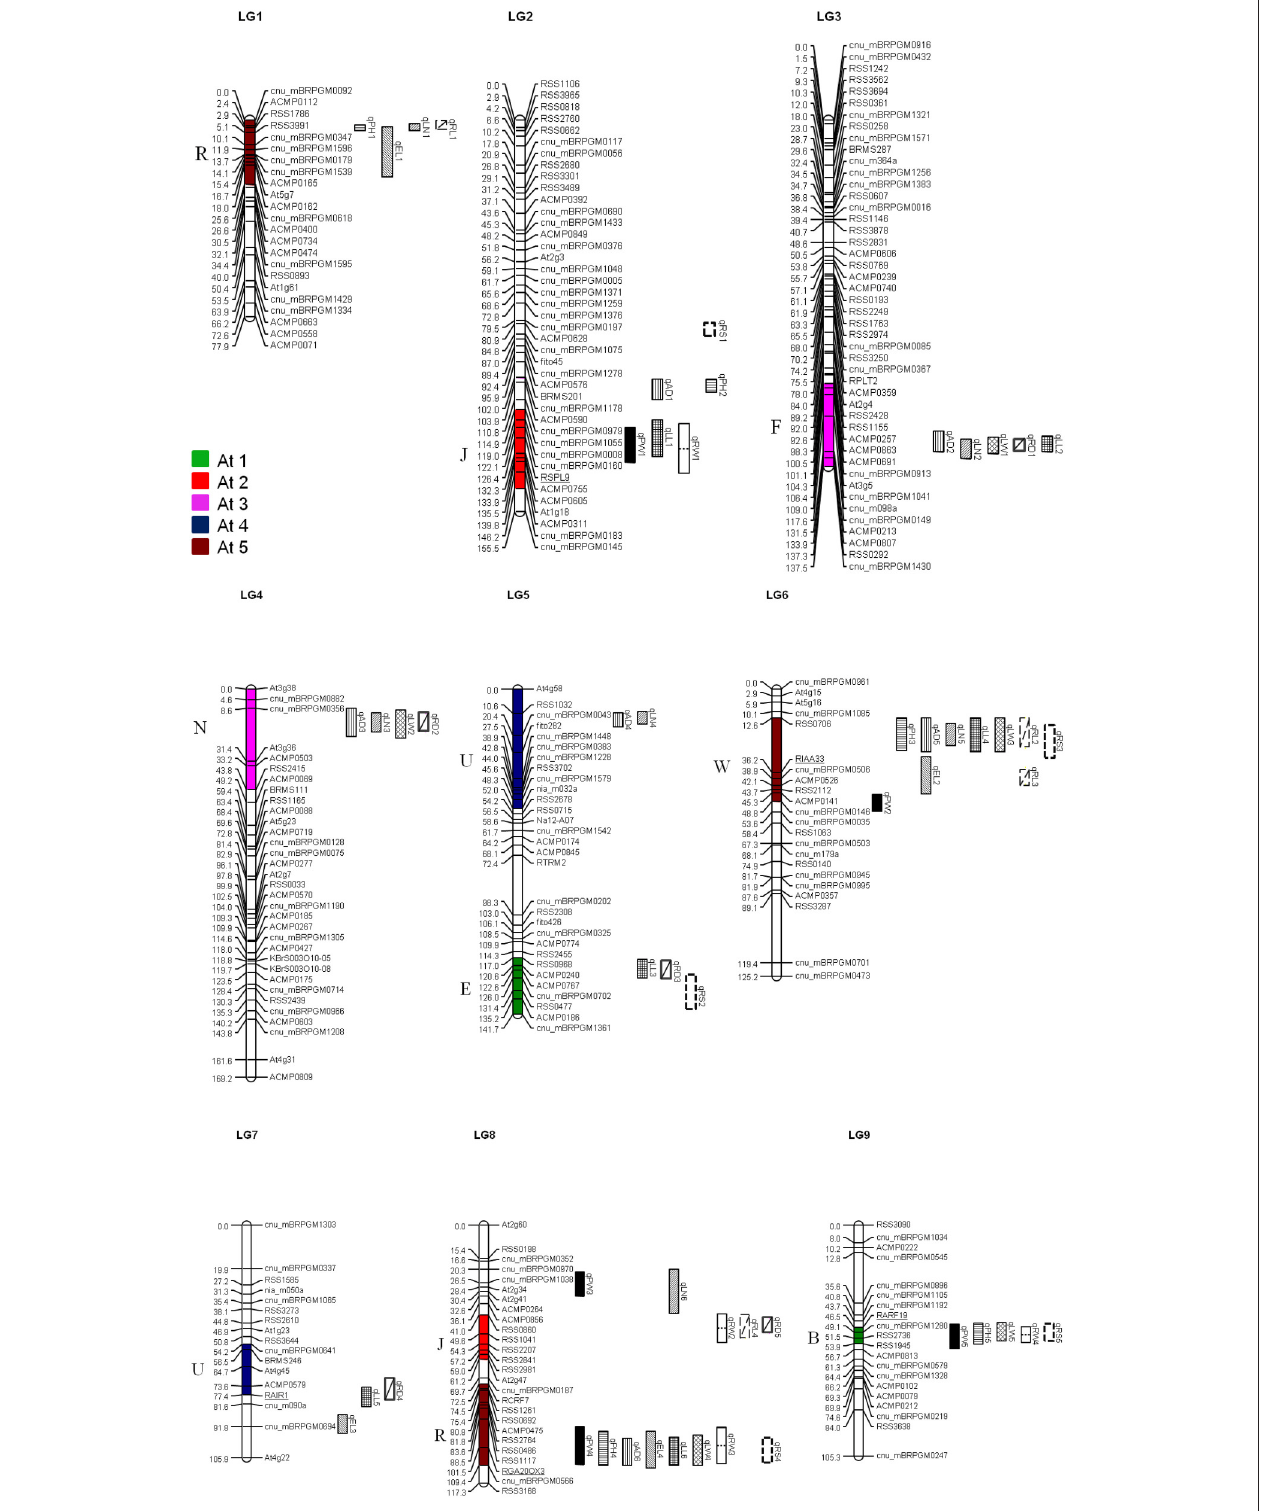
FIGURE 1 | Distribution of QTL for morphological and yield traits in the R. sativus genome. QTL names are indicated by using the same abbreviations of trait names given in Table 1 . Numbers in parenthesis indicate the year of QTL detection. The crucifer building blocks in each LG of R. sativus which are homologous to the five chromosomes of A. thaliana (At C1–At C5) are indicated by different colors.